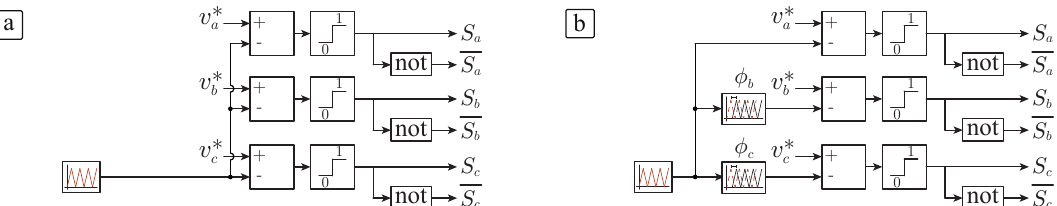
Figure 2. Modulation method of a three-phase two-level motor drive ( a ) Traditional PWM method with a single carrier ( b ) PWM technique with three